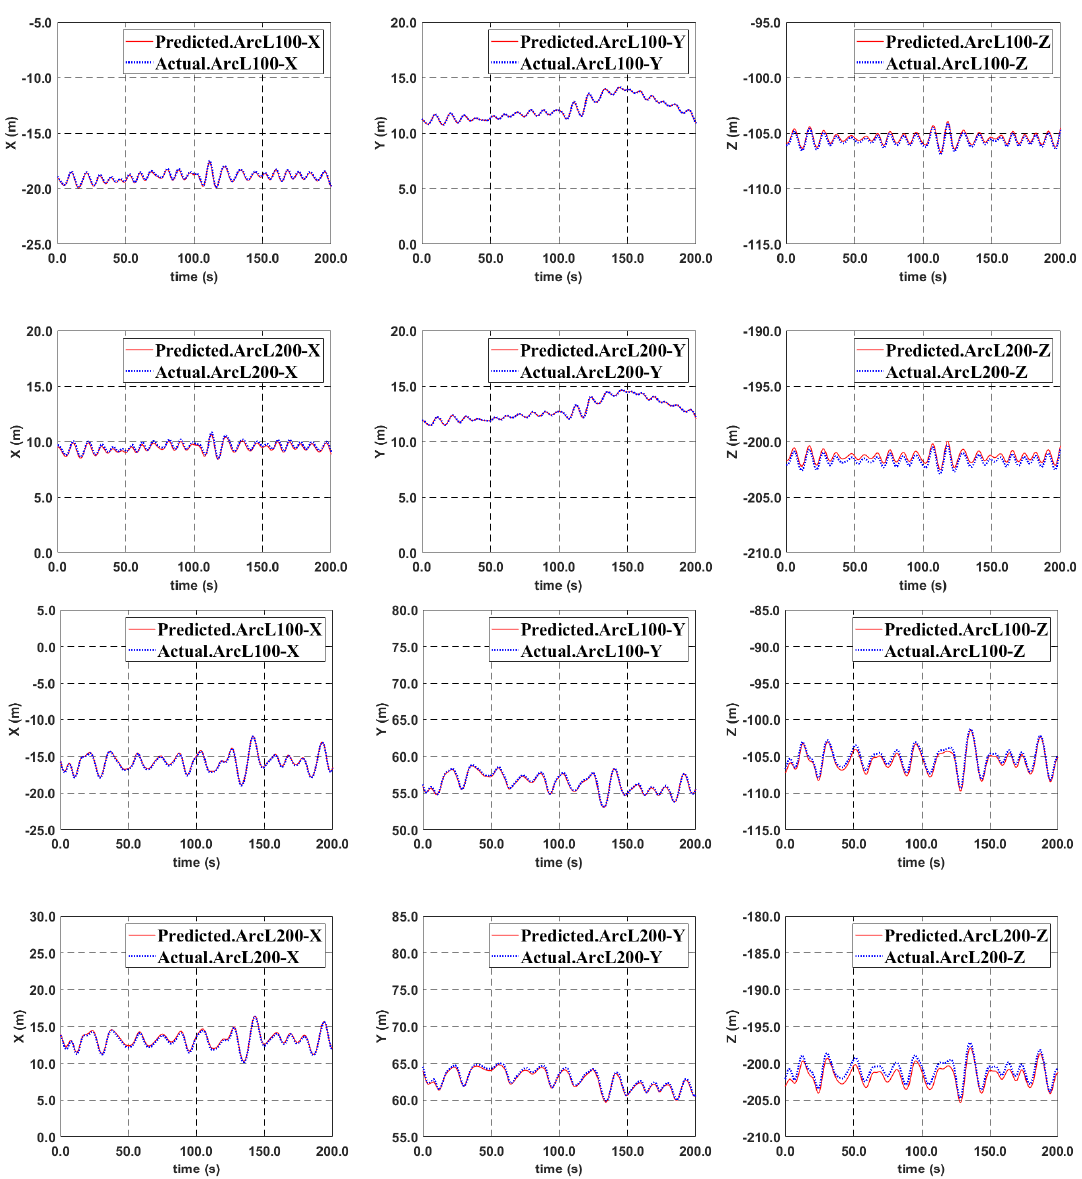
Figure 14. Displacement Tracing up to Target Point (200 m Arc length), 1-yr Storm ( Up ) and 100-yr Storm ( Down ), WD1000, SLWR, Sensor Interval = 100 m.